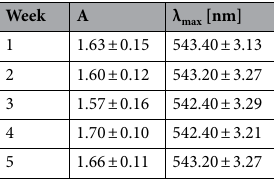
Table 1. The arithmetic mean and standard deviation of absorption intensity (A) and absorbance maxima λ max Au colloids prepared in parallel.